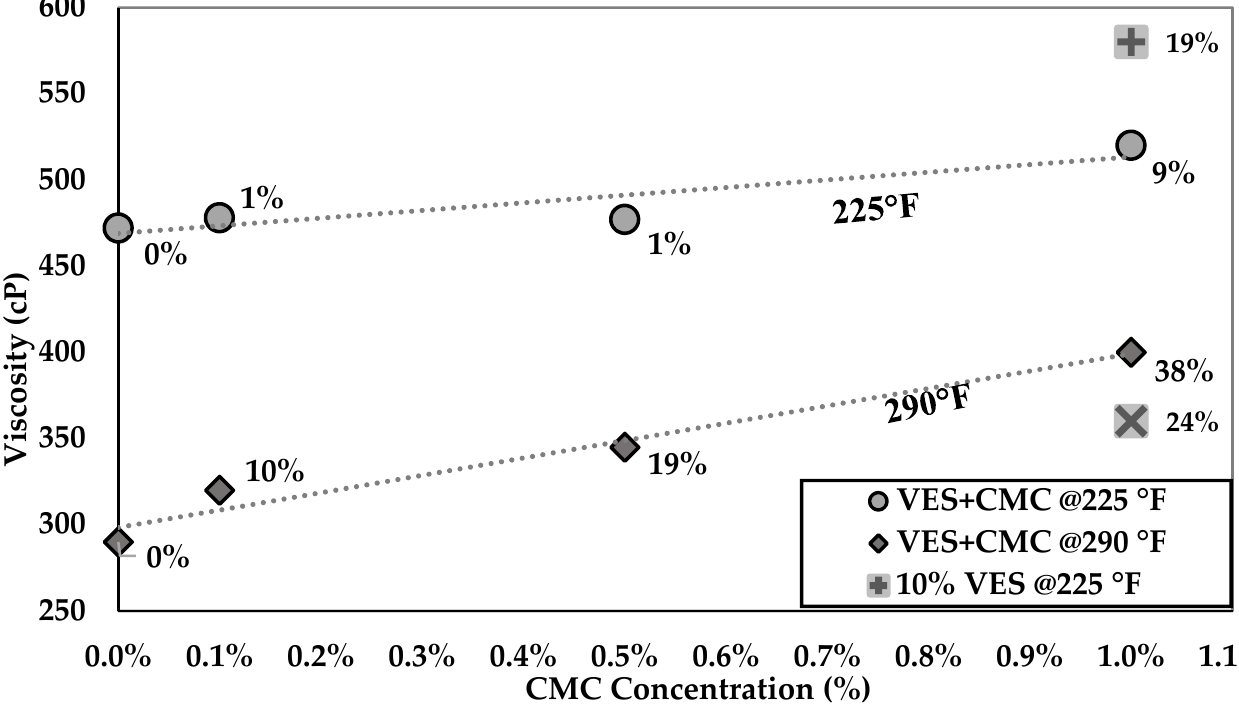
tures. During hydraulic fracturing, a higher viscosity is preferred during injection (2–3 h